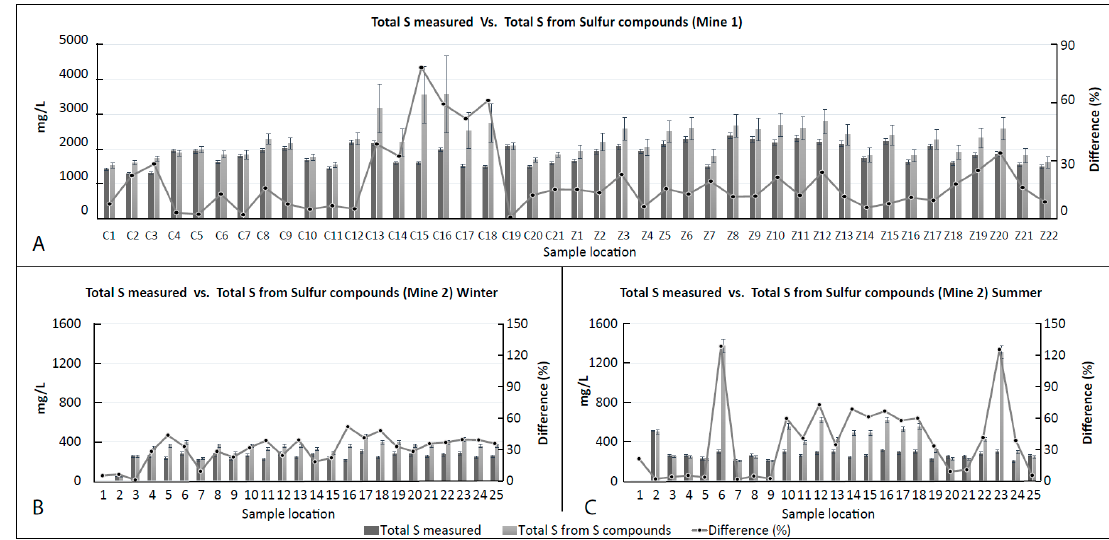
Figure 4. Balance of sulfur calculated for samples from Mine 1 ( A ) and Mine 2 winter survey ( B ) and summer survey ( C ).